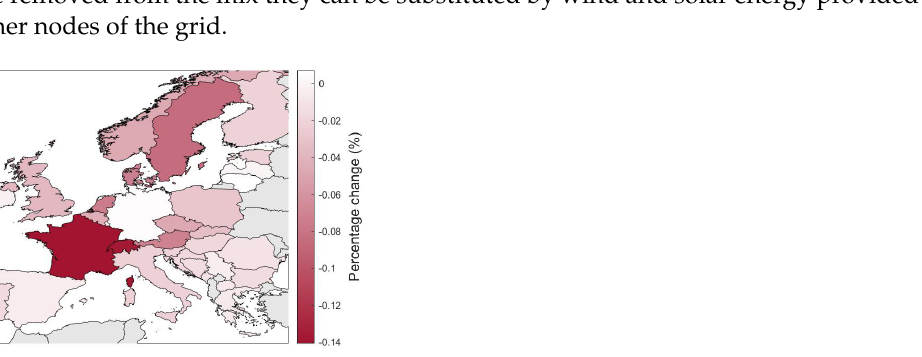
Figure 12. Percentage change in the hypervolume indicator with the exclusion of each country from the generation